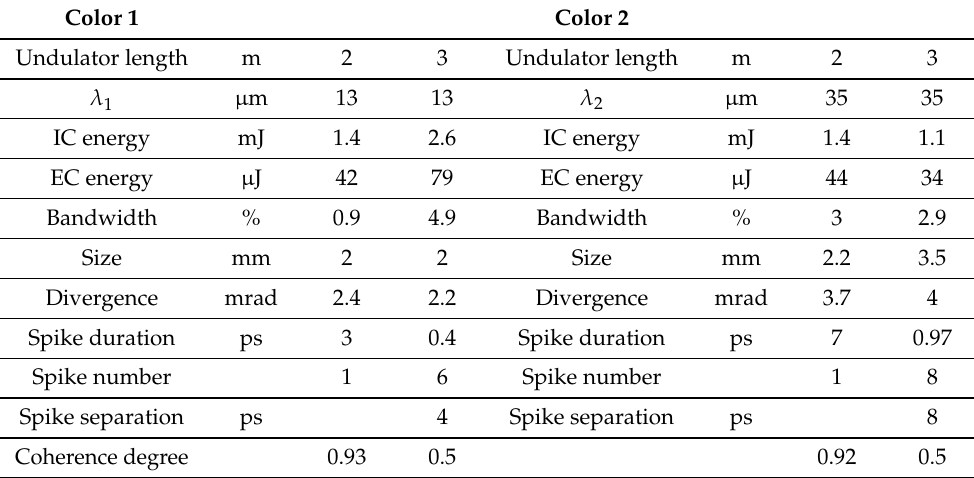
Table 3. Radiation properties of the two-color source. IC = intracavity, EC = extra-cavity.